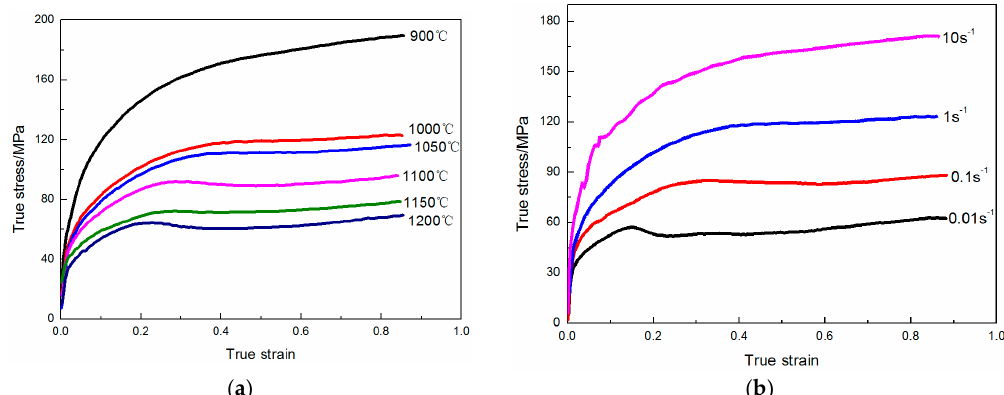
ε  . ε = 1 s − 1 and = 1 s − 1 ε  = 1 s − 1